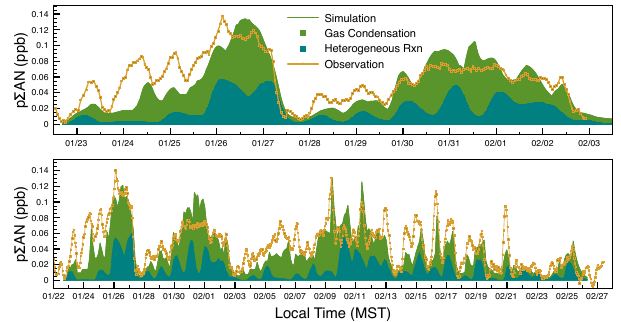
Figure 6. Time series of predicted particulate organic nitrate con- centration from box model simulation for two accumulation events (top panel) and the campaign period (bottom panel) as stacked areas showing contribution from each of the two mechanisms responsible. The observations are plotted in